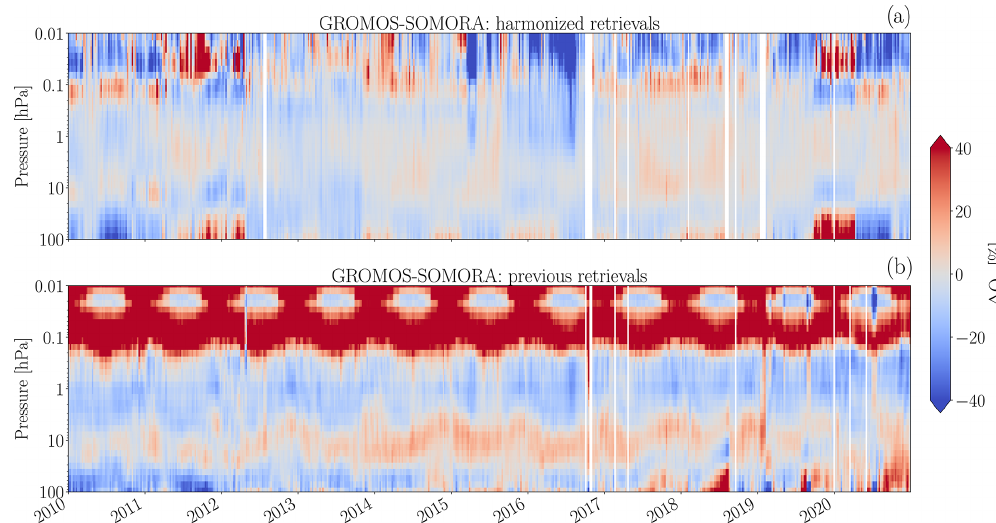
Figure 6. Weekly ozone relative difference between the new (a) and previous (b) GROMOS and SOMORA series.